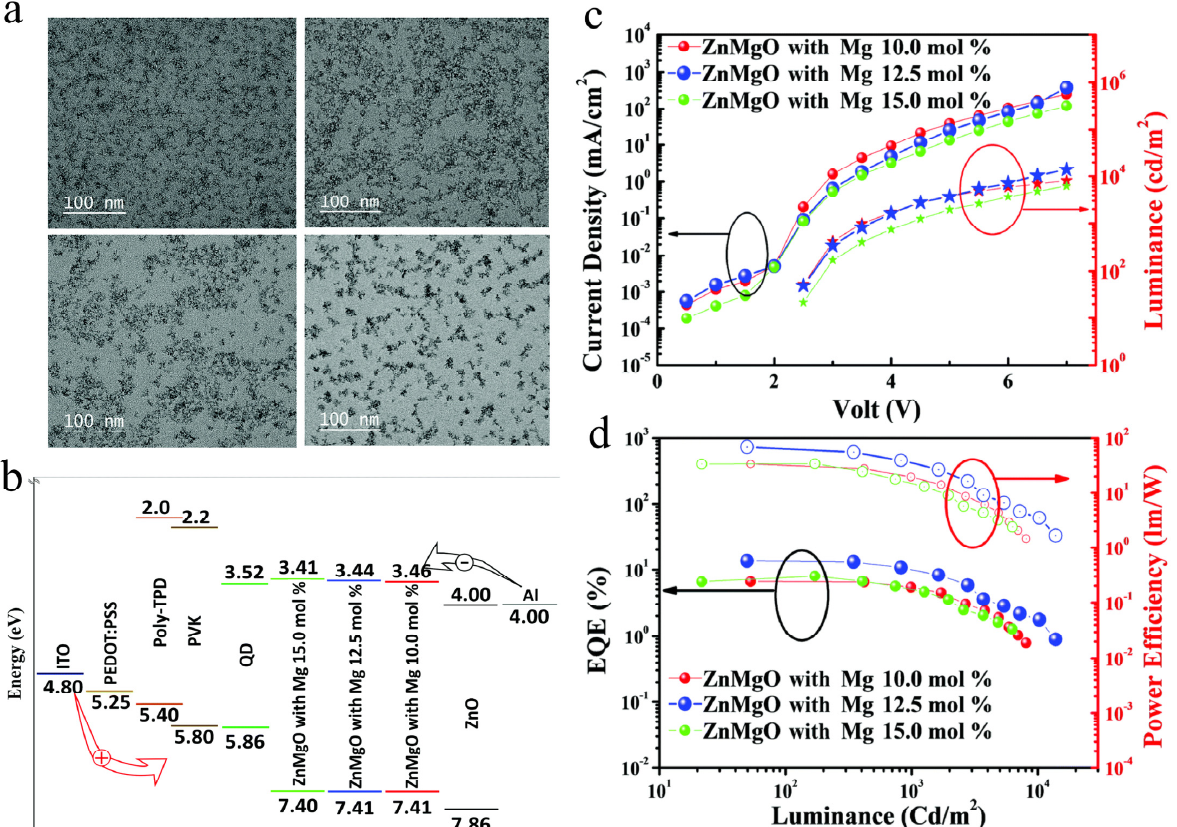
Figure 13. TEM images of ( a ) ZnO. ZnMgO with ( b ) 10.0 mol% Mg, and ( c ) 12.5 mol% Mg, and ( d ) 15.0 mol% Mg. ( b ) Band structure diagram of the InP QLED. ( c ) Current density − voltage − luminance curves of QLEDs fabricated with ETLs with different Mg contents. ( d ) EQE − luminance − power effi- ciency curves of QLEDs fabricated with ETLs with different Mg contents. Reprinted with permis- sion from Ref. [33]. © 2019, The Royal Society of Chemistry.